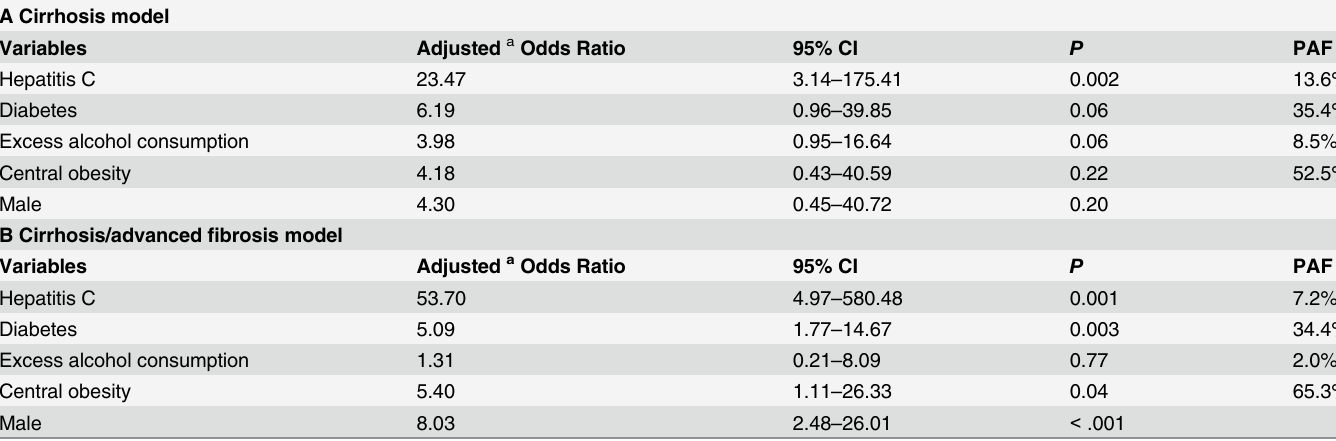
Table 3. Factors Associated with cirrhosis (APRI (cid:1) 2) and cirrhosis/advanced fibrosis (APRI (cid:1) 1) based on multivariable logistic regression